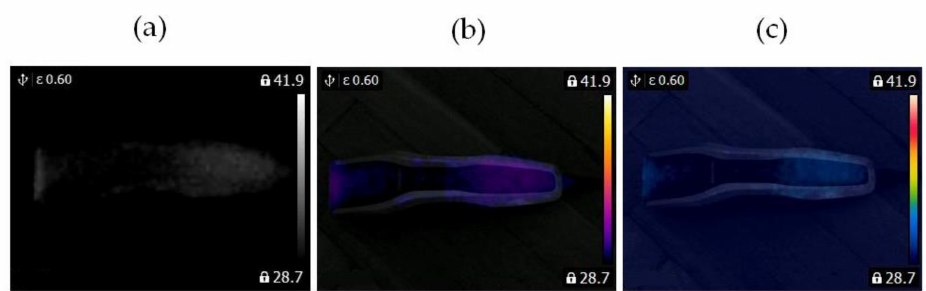
Figure 8. Analyzed clipper HC5440/80: ( a ) healthy clipper, ( b ) blocked ventilation of the clipper.